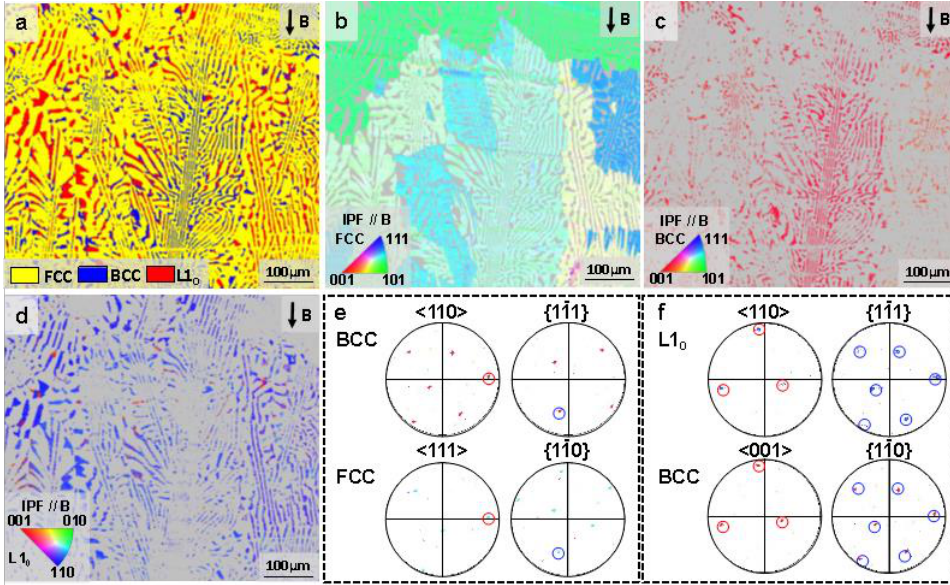
Figure 11. EBSD results for the 10 T sample. ( a ) Phase map; ( b ) IPF map of FCC phases; ( c ) IPF map of BCC phases; ( d ) IPF map of L1 0 phases; ( e ) pole figures of FCC and BCC phases in single eutectic colony. The pole points on the (1-11) (blue circle) and [110] (red circle) pole figures of the BCC phase overlap with those on the (1-10) (blue circle) and [111] (red circle) pole figures of the FCC phase; ( f ) pole figures of L1 0 martensite and BCC austenite. The pole points on the (1-11) (blue circle) and [110] (red circle) pole figures of the L1 0 phase overlap with those on the (1-10) (blue circle) and [001] (red circle) pole figures of the BCC austenite phase, implying the preferred orientation relationship.